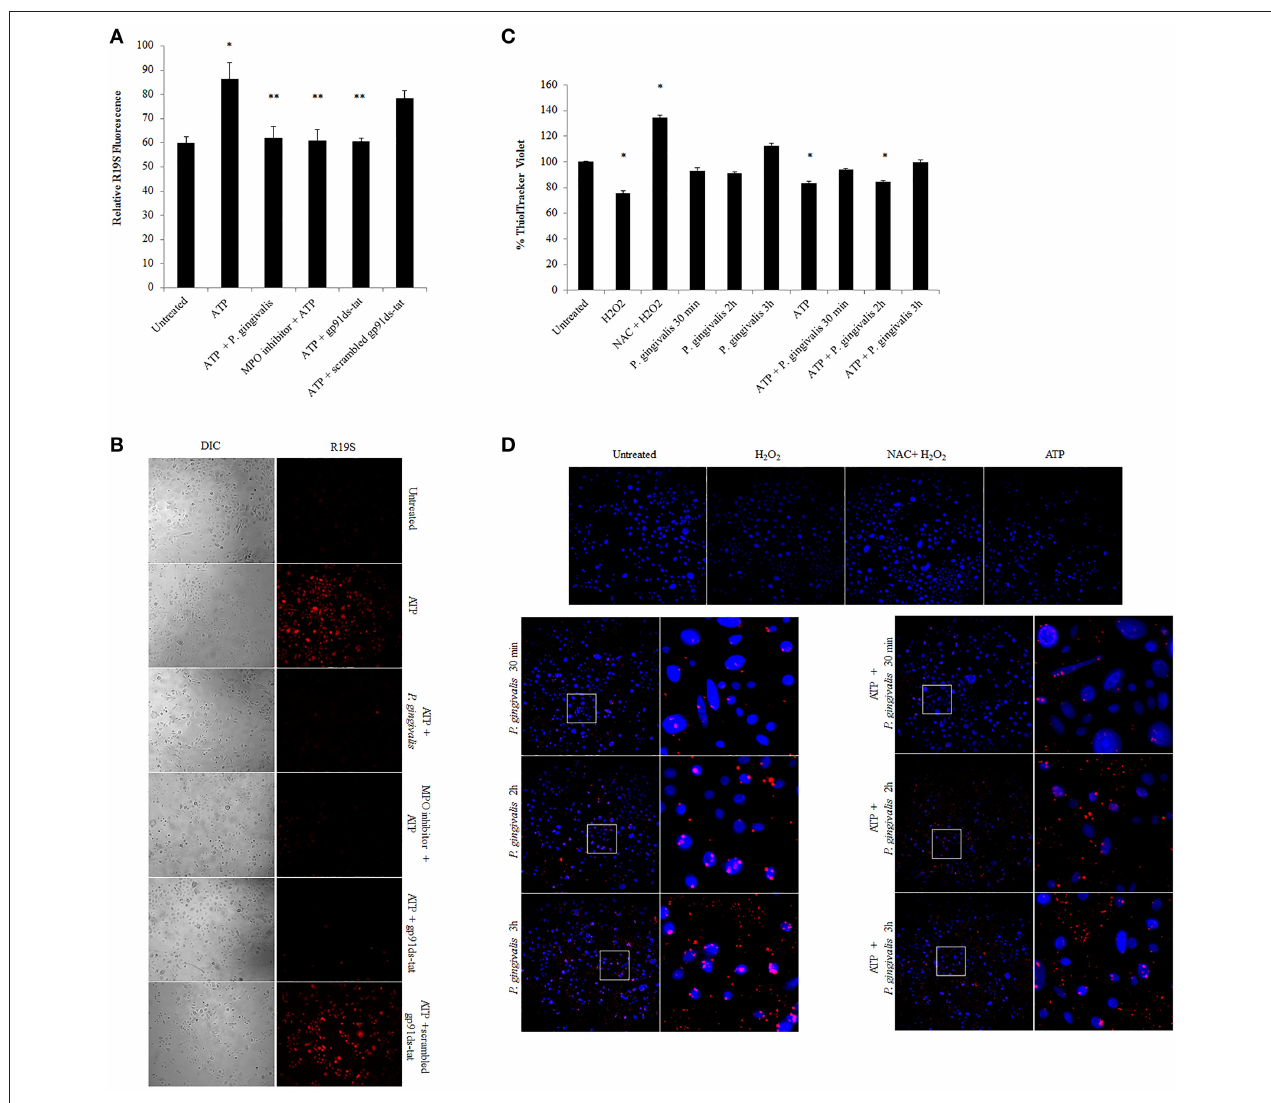
FIGURE 7 | P. gingivalis reduces ATP-driven hypochlorous acid production in primary GECs through Glutathione. (A) Measure of R19S (10 µ M) probe fluorescence, detecting HOCl production, using a Biotek H1M monochromatic plate reader at 545 nm in ATP (3 mM) pre-treated and 2 h P. gingivalis (MOI100) infected cells. The MPO inhibitor (1 µ M) and gp91ds-tat (50 µ M) were added to the cells as described in the Methods Section. N = 3, * p < 0.05 ATP compared to untreated; ** p < 0.05 inhibitor treatments and P. gingivalis infection pre-treated with ATP as compared to ATP only condition. (B) Micrographs of live representative images of the